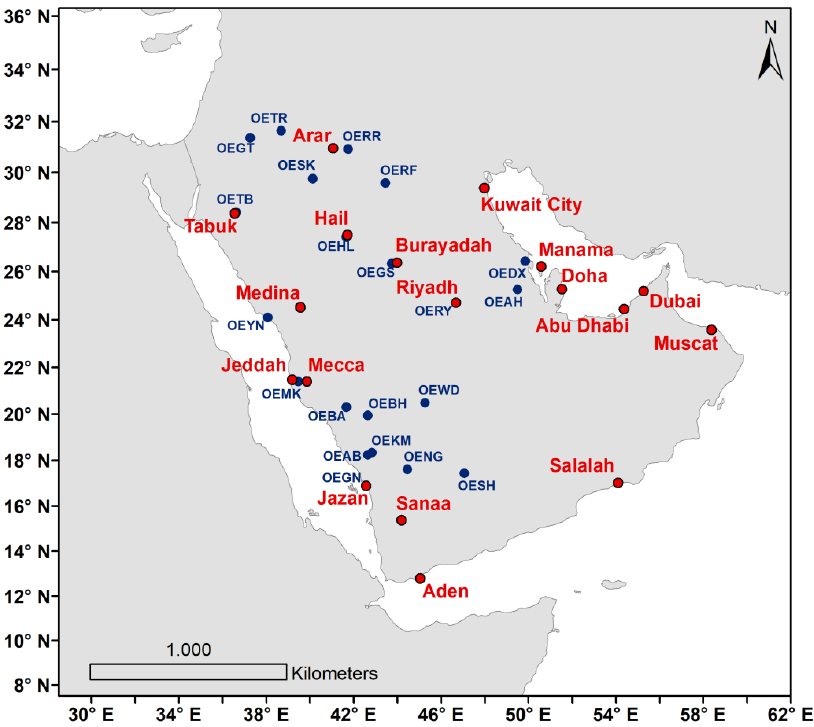
Figure 1. The model domain employed for the study. The locations and the codenames of the stations used for the evaluation study are depicted with blue. The locations selected for the application of the Intensity–Duration–Frequency analysis are marked in red.